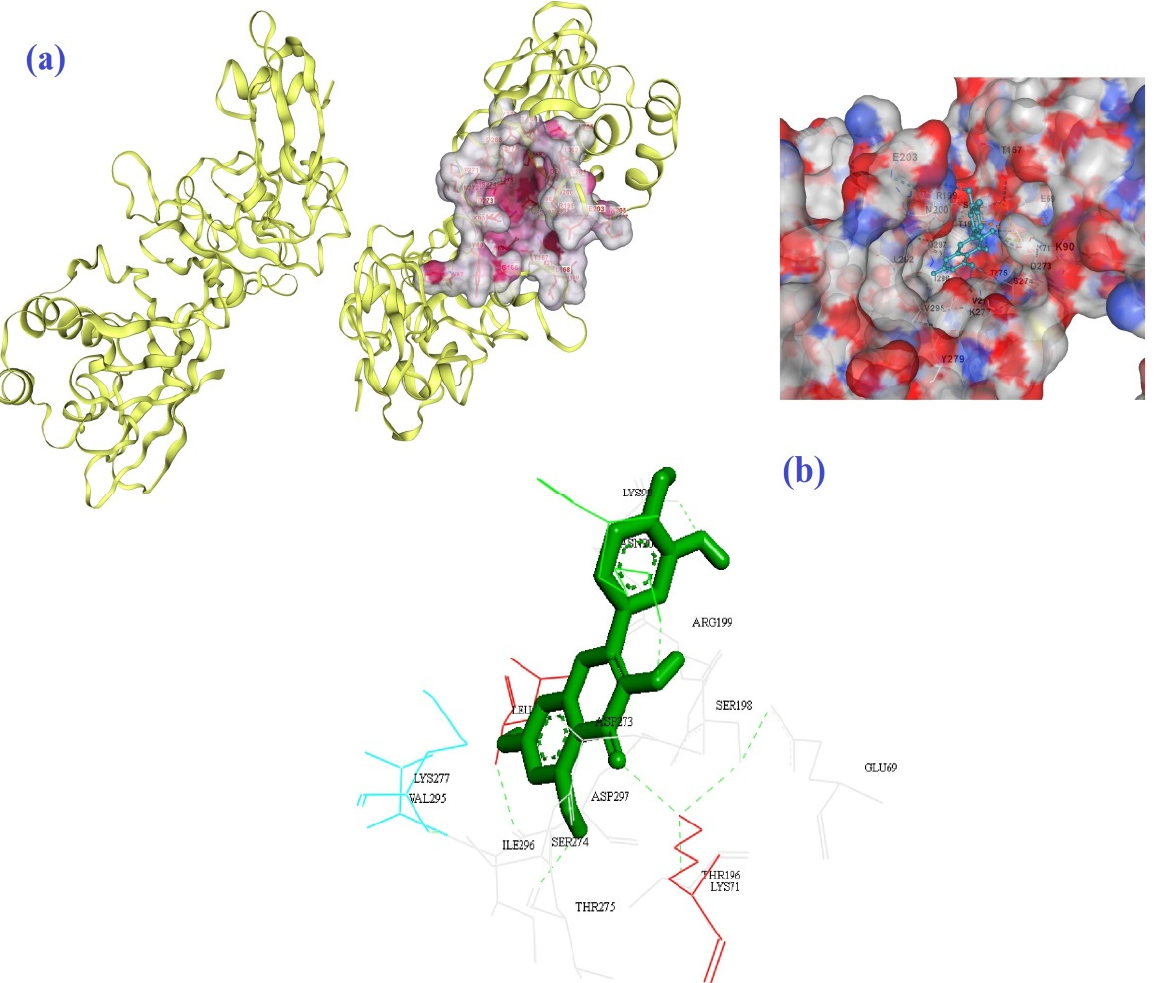
Figure 6. The best mode of the active site for the receptor of 6VWW ( a ) and its interaction with quercetin ( b ) according to the results of CB-Dock.